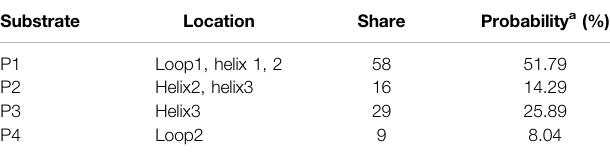
TABLE 3 | Location, number, and probability of trajectories for peptide delivery channels from RAMD MD calculations. Substrate